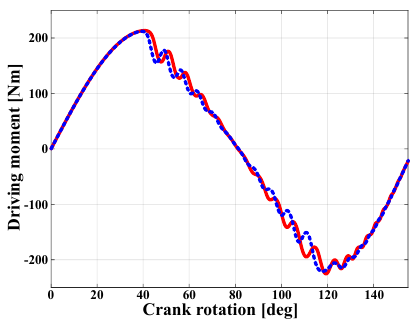
Figure 17. Driving moment for the revolute joint at point G : plate model (solid line); beam model (dashed